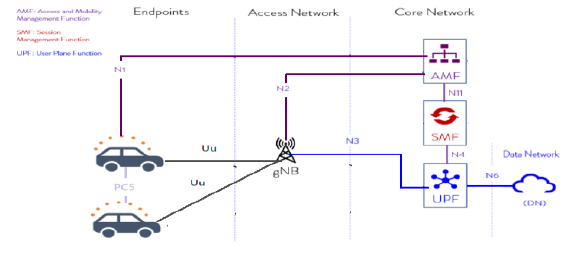
FIGURE 2. 5G-V2X